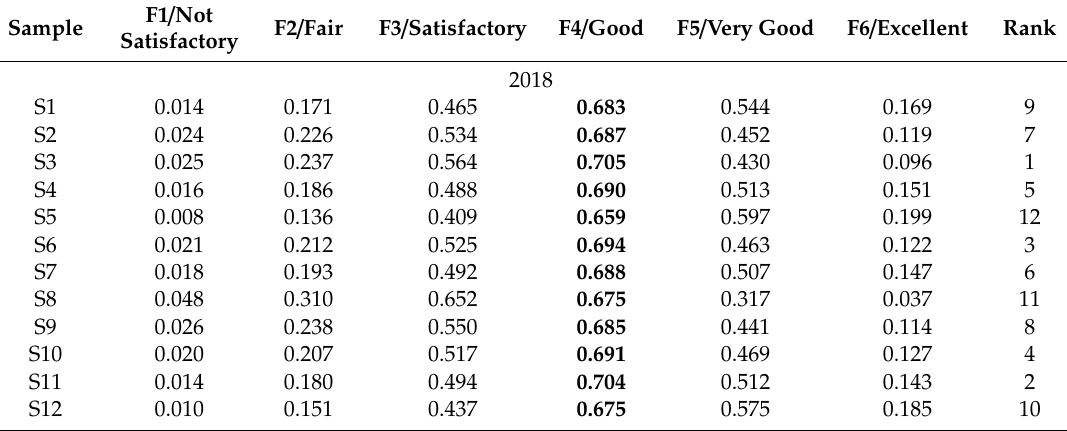
Table 1. Similarity values for pear